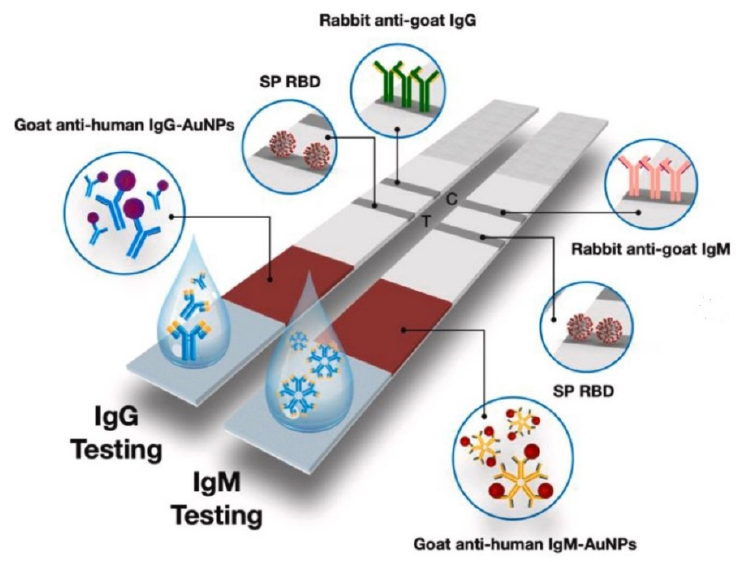
Figure 12. Schematic diagram of the LFIA calorimetric test strips. Reprinted with permission from Elsevier B.V. [57], Copyright (2020).